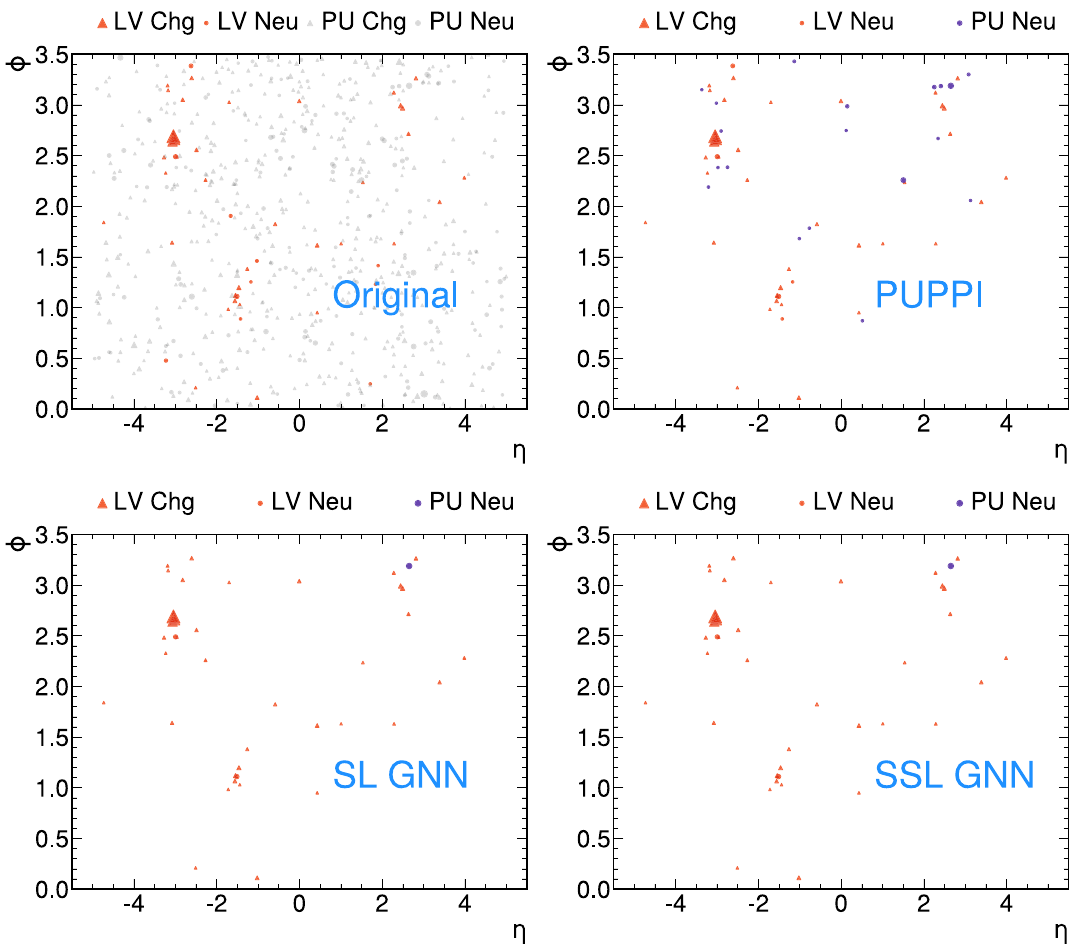
Fig. 7 Some event display examples of the particle distributions in the η − φ space. The upper left plot is using ground truth information. The upper right plot is after applying PUPPI. The lower left and right plots are after applying SL and SSL,